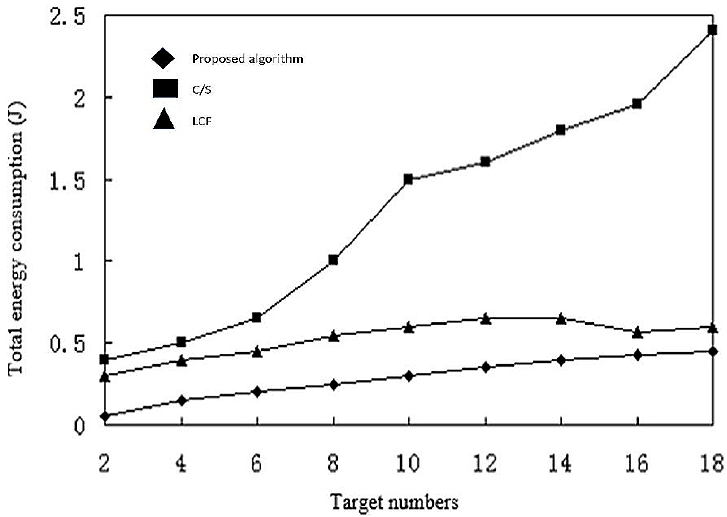
Figure 17. Energy consumption.